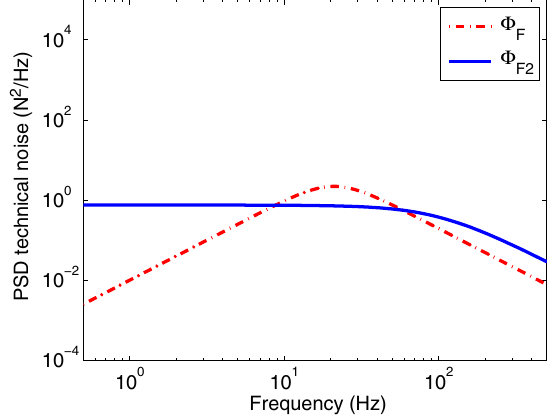
FIG. 10. Power spectral densities of the two technical noise assumptions. Φ is the technical noise applied on the detector and F Φ is the technical noise applied on QD0. F 2